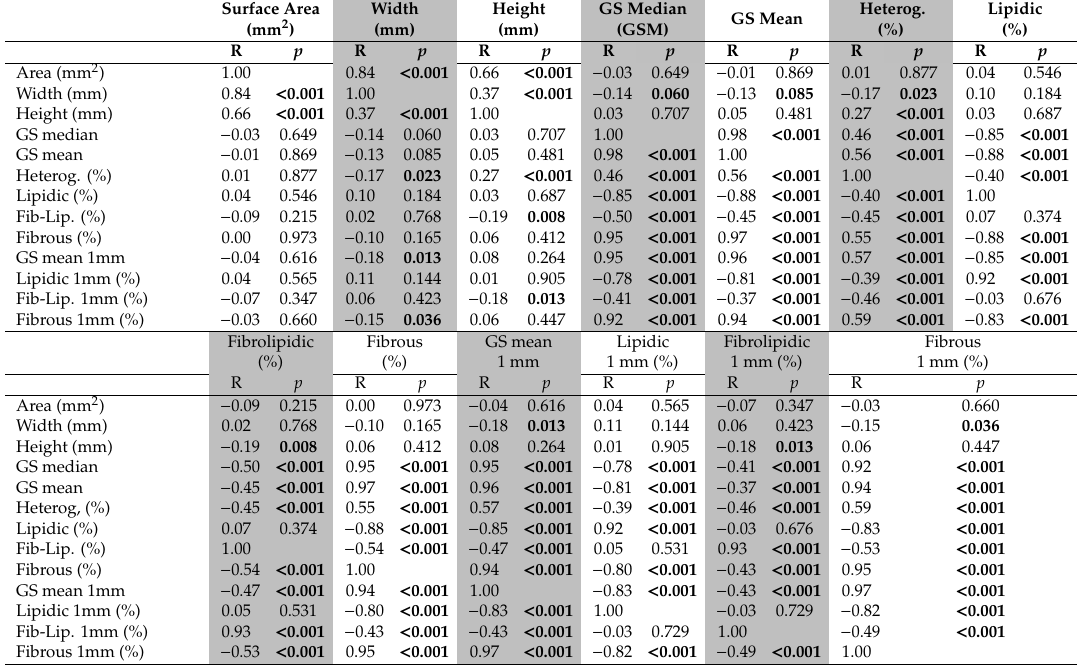
Table 6. Bivariate association between plaques geometry and composition ( n = 206) .